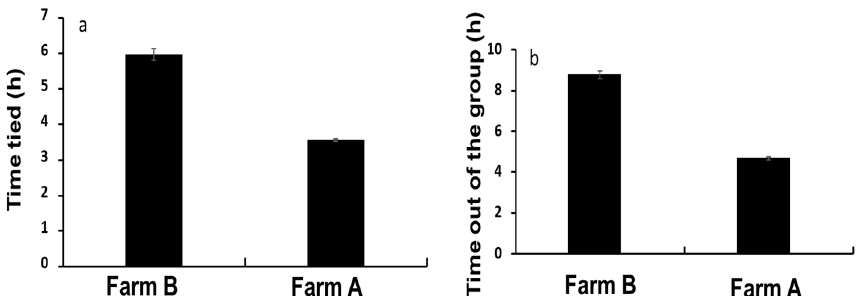
Figure 2. Time cows were tied up ( a ) and away from their group ( b ) while waiting for rectal palpation test in the two different dairy farms A and